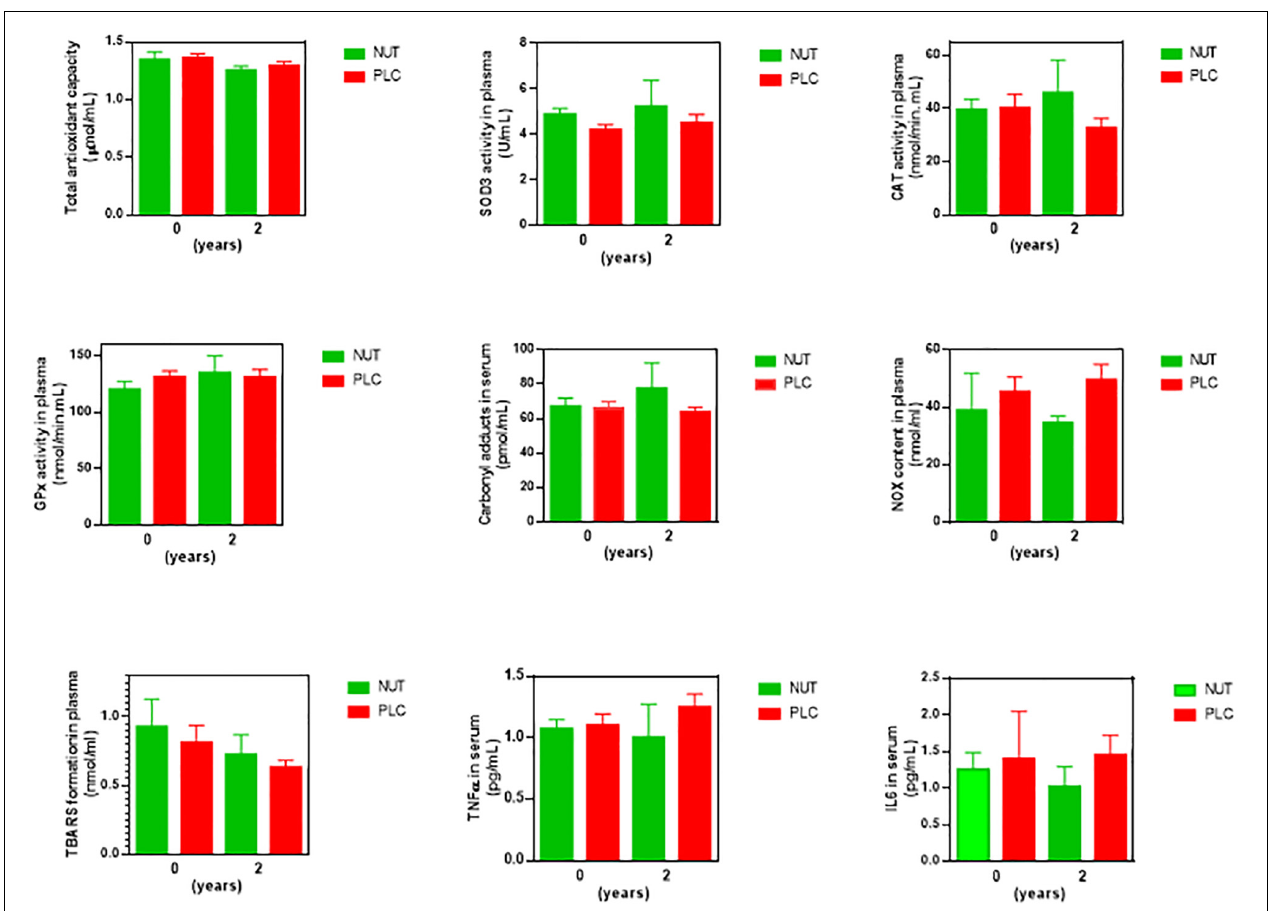
FIGURE 7 | Concentrations of antioxidant, oxidant, and inflammatory markers in blood of RP patients after 2 years of supplementation. Peripheral redox status was determined by measuring total antioxidant capacity (TAC), extracellular superoxide dismutase (SOD3), and catalase (CAT) activities, lipid peroxidation (TBARS formation), nitric oxide metabolites (NOX), and protein carbonyl adduct (CAR) content with commercial kits. Serum cytokines were measured by commercial enzyme immunoassay kits. All data were plotted in bar graph with standard error bars. NUT, patients with RP who daily received a mixture of nutraceuticals; PLC, patients with RP who daily received placebo; TBARS, thiobarbituric acid reactive substances; NOX, nitrites and nitrates.